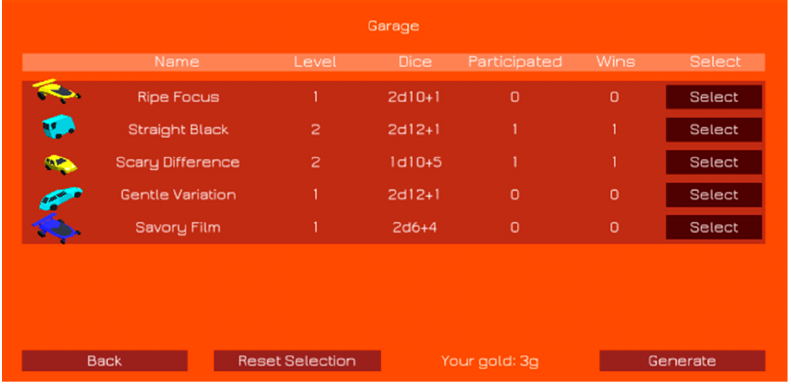
Figure 1. Garage view of the